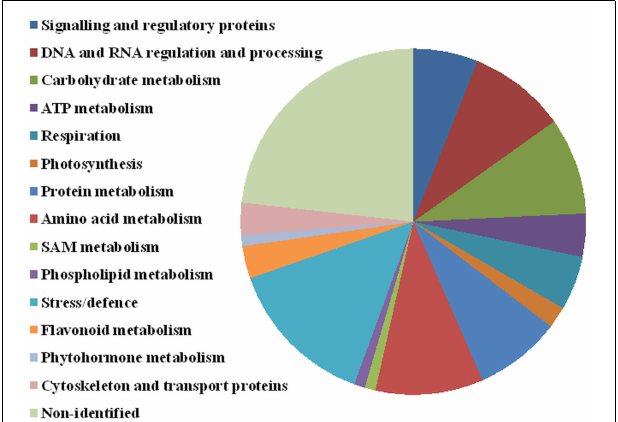
FIGURE 6 | Protein functional annotation. Selected 99 protein spots were categorized into the following functional categories: signaling and regulatory proteins (6 spots), DNA and RNA regulation and processing (9 spots), carbohydrate metabolism (9 spots), ATP metabolism (4 spots), respiration (5 spots), photosynthesis (2 spots), protein metabolism (8 spots), amino acid metabolism (10 spots), SAM metabolism (1 spot), phospholipid metabolism (1 spot), stress and defense (14 spots), flavonoid metabolism (3 spots), phytohormone metabolism (1), cytoskeleton and transport (3 spots), and non-identified (23